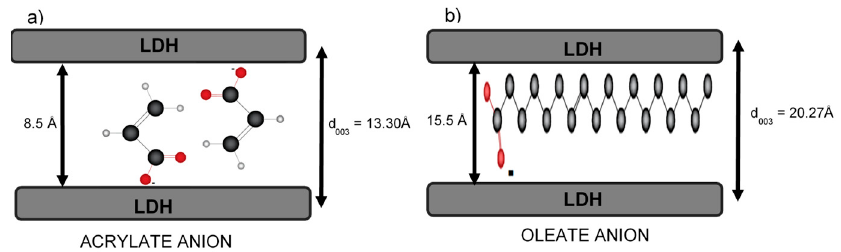
Figure 4. Intercalation scheme of: ( a ) acrylate and ( b ) oleate anions in LDH materials.